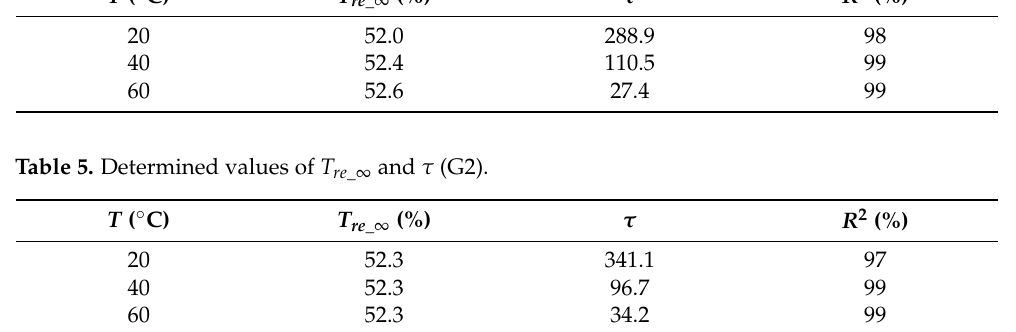
Figure 18. 𝑇 (cid:3045)(cid:3032) − 𝑡 fi(cid:308)ing curves under different temperatures based on the second prediction Figure 18. T re − t fitting curves under different temperatures based on the second prediction model: model: ( a ) G2; ( b ) G2. ( a ) G2; ( b ) G2. Table 4. Determined values of 𝑇 (cid:3045)(cid:3032)_(cid:2998) and 𝜏 (G1). Table 4. Determined values of T re _ ∞ and τ (G1). T (°C)